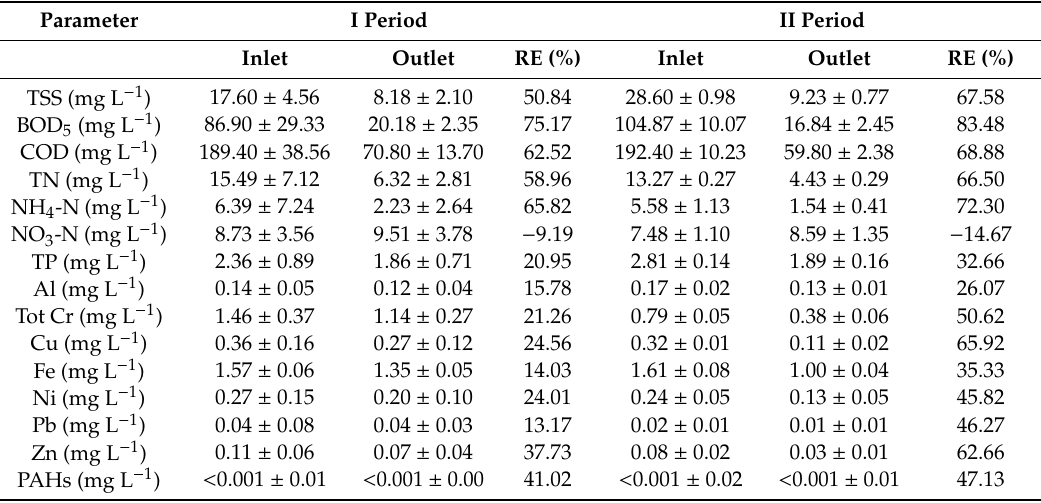
Table 2. Main chemical and physical composition of the FFSW from the inflow and outflow of the VSSFs CW. Removal e ffi ciency from October 2018 to July 2019. Average values ( ± standard deviation) are shown ( n =